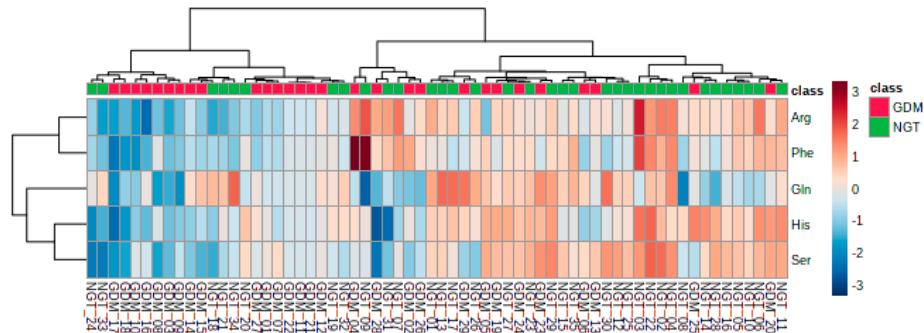
Figure 4. Clustering result is shown as heatmap (distance measure using Euclidean, and clustering algorithm using Ward’s method) for five most significant amino acids. Data are log-transformed and standardized.